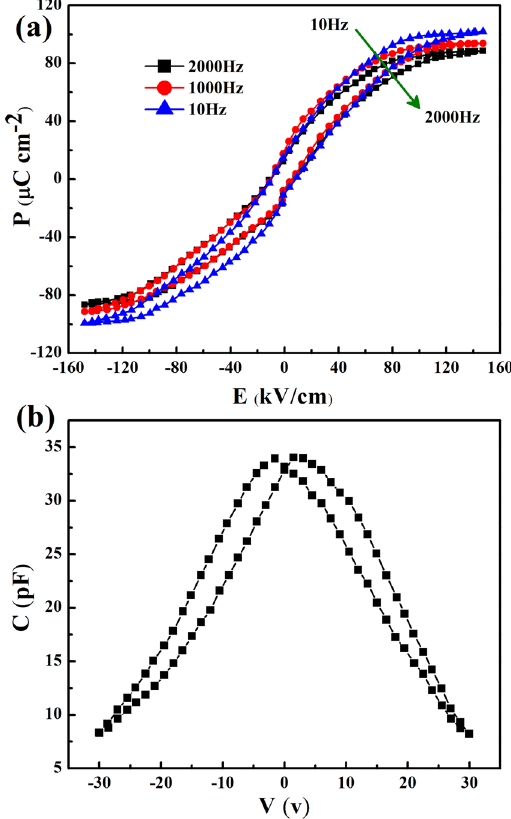
Figure 3. Evidence of ferroelectric behaviour in a SL with layer period of (3, 15). ( a ) P-E hysteresis loops measured at T = 30 K from 10 Hz to 2 kHz. ( b ) Capacitance–voltage ( C-V ) characteristic loop measured at T = 30